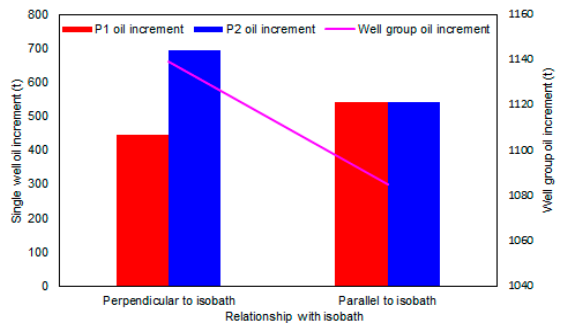
Figure 22. Oil increment of different relationships with isobaths.